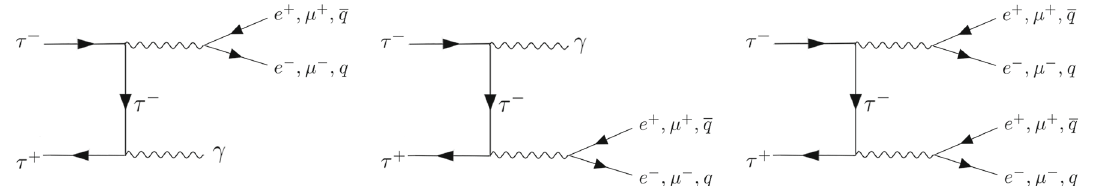
Fig. 5 Left and center: Diagrams for Dalitz decays of para-ditauonium (NLO real corrections to the diphoton n 1 S 0 width). Right: “Double Dalitz” (4-fermions) NNLO real correction of the para-ditauonium decay